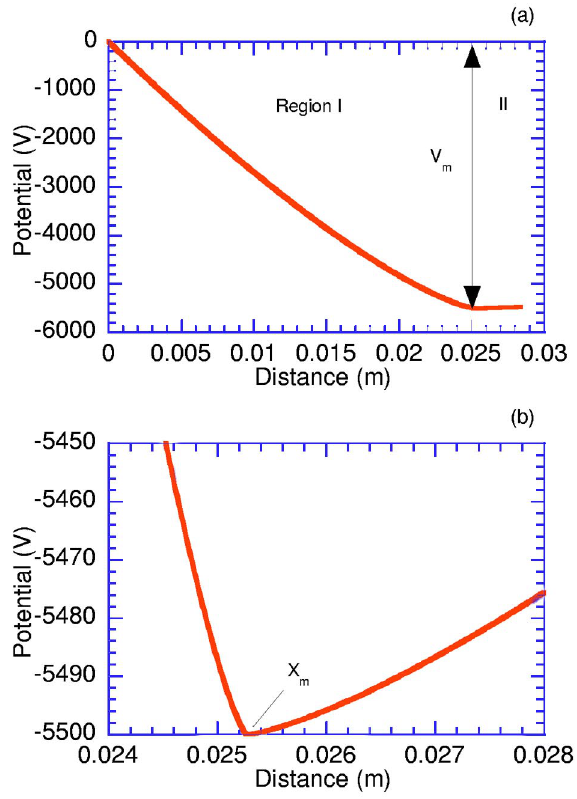
FIG. 6. (Color) Potential distribution with a virtual cathode. Beam energy is 5500 eVand the retarding voltage is (cid:7) 5470 V . (a) Full potential range. (b) Enlarged at the vicinity of the virtual